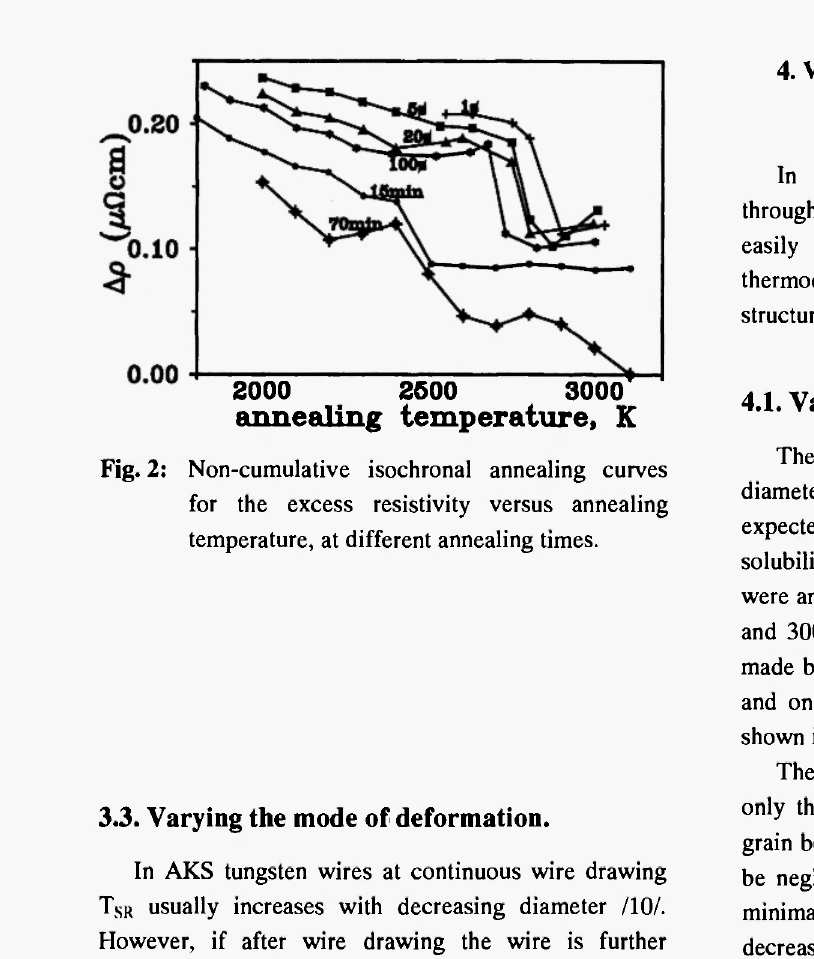
Variation in the recrystallization temperature, T SR , when the wires are further deformed by coiling or torsion, and the grain aspect ratios (G.A.R.).